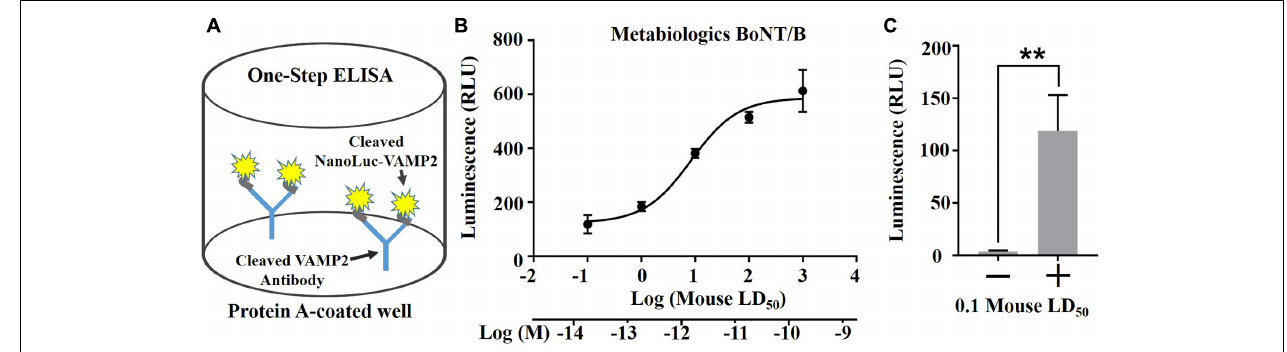
FIGURE 5 | One-step ELISA assay using the NanoLuc-VAMP2 construct. (A) Schematic (left) showing the principle of one-step ELISA. The cleaved VAMP2 antibody was immobilized on Protein A plates for capture of the BoNT/B-cleaved VAMP2 construct. (B) Graph showing the dose-dependent detection